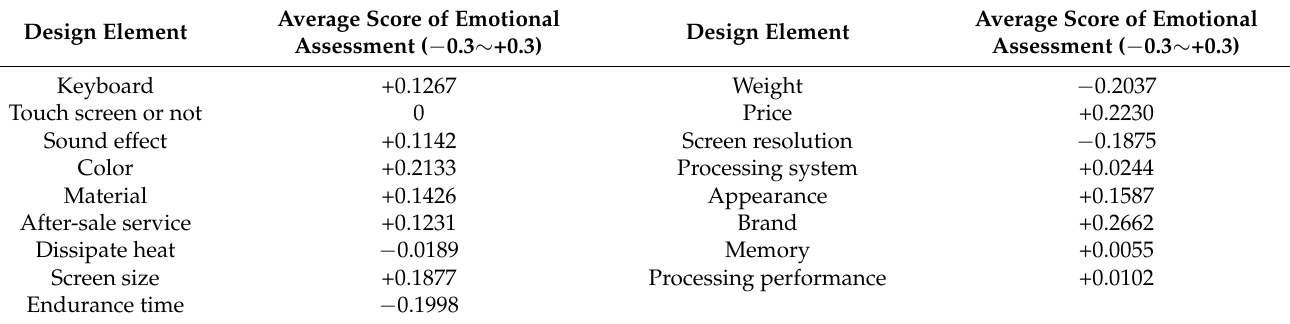
Table 6. Design elements’ emotional evaluation